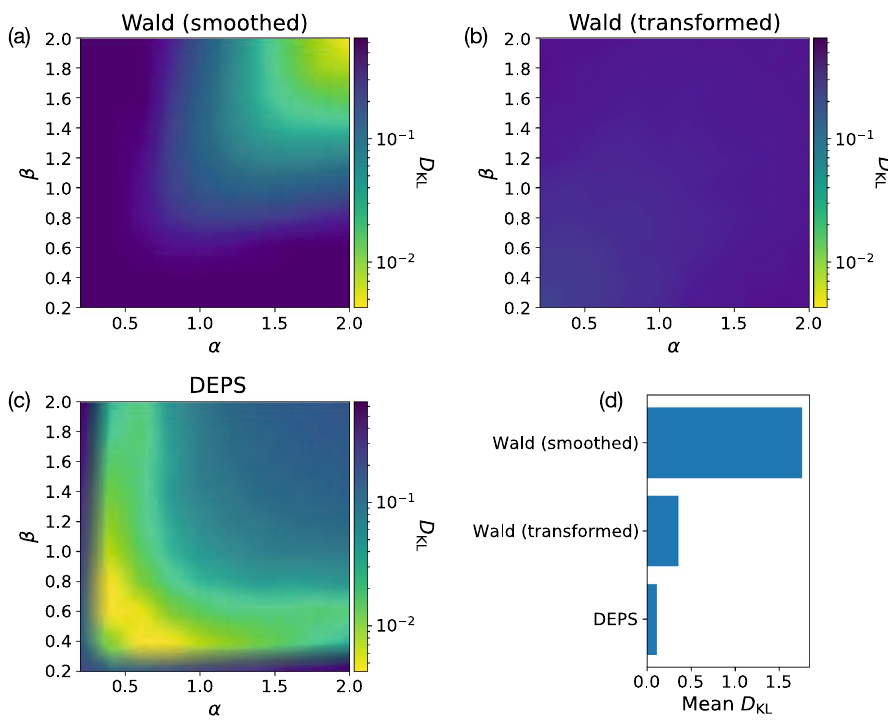
Figure 6. The KL-divergence (or relative entropy) D KL between the inferred and true distributions of p over a range of parameters for the true distribution. Here we see that DEPS outperforms the Wald baselines for most parameter values, achieving a lower divergence in its estimates of the true distribution. Panel d shows the mean KL-divergence averaged over the values of α and β in the matrices shown in panels a – c